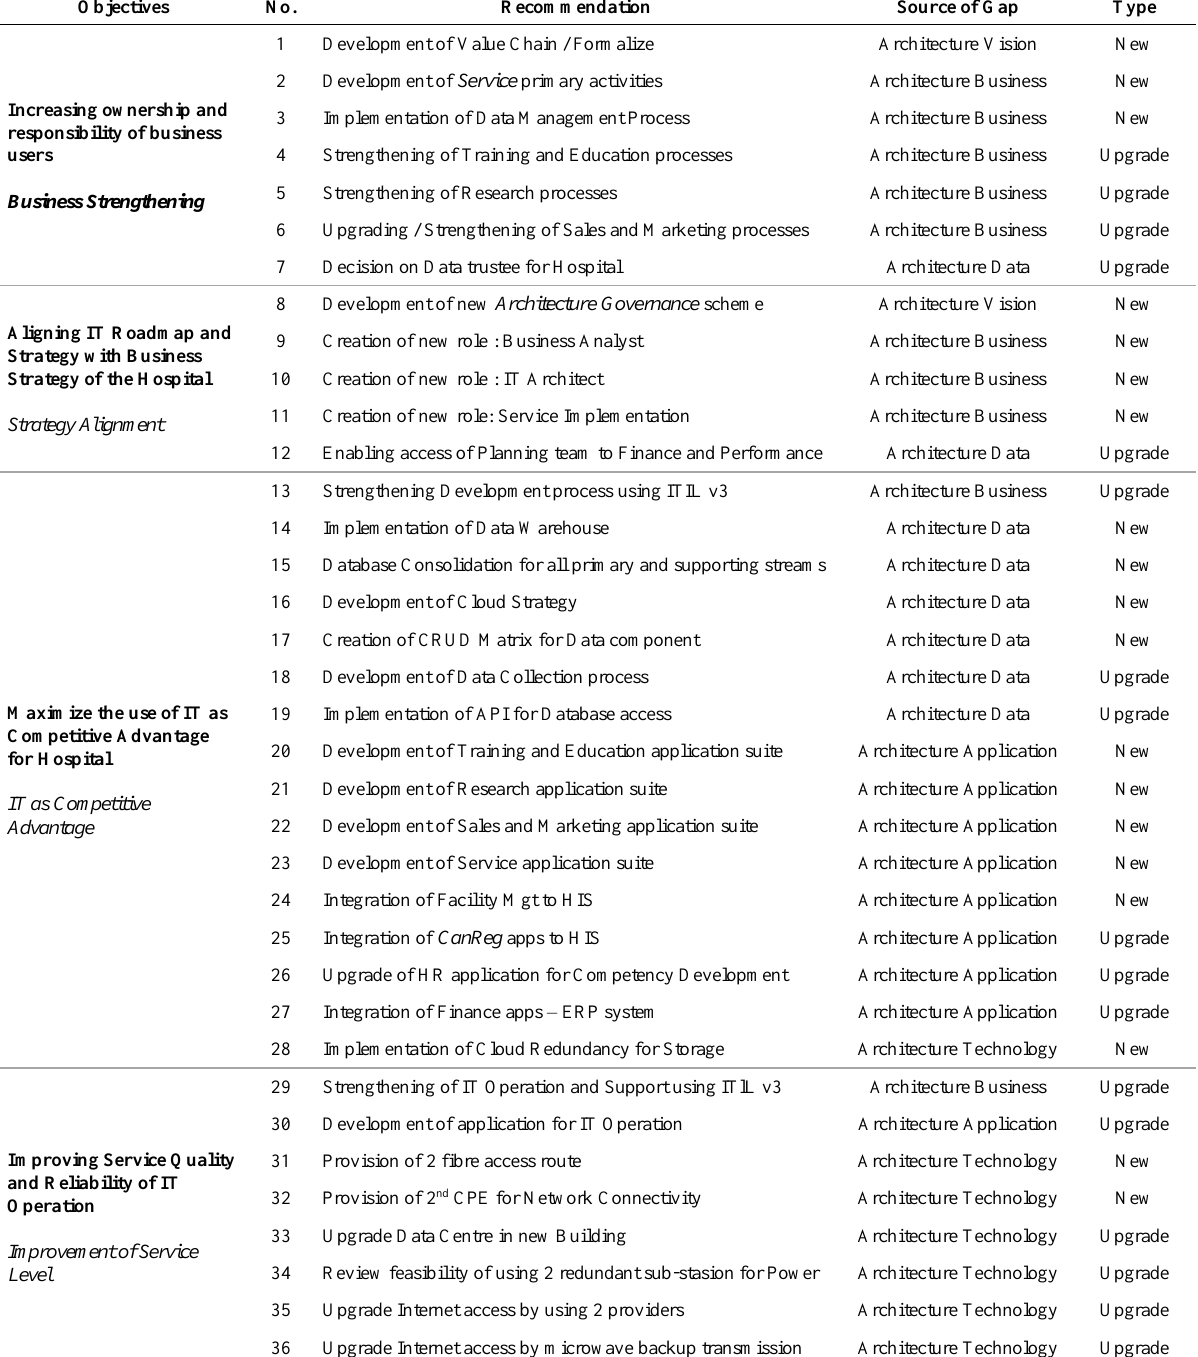
Table 3. Consolidation and Mapping of Gap